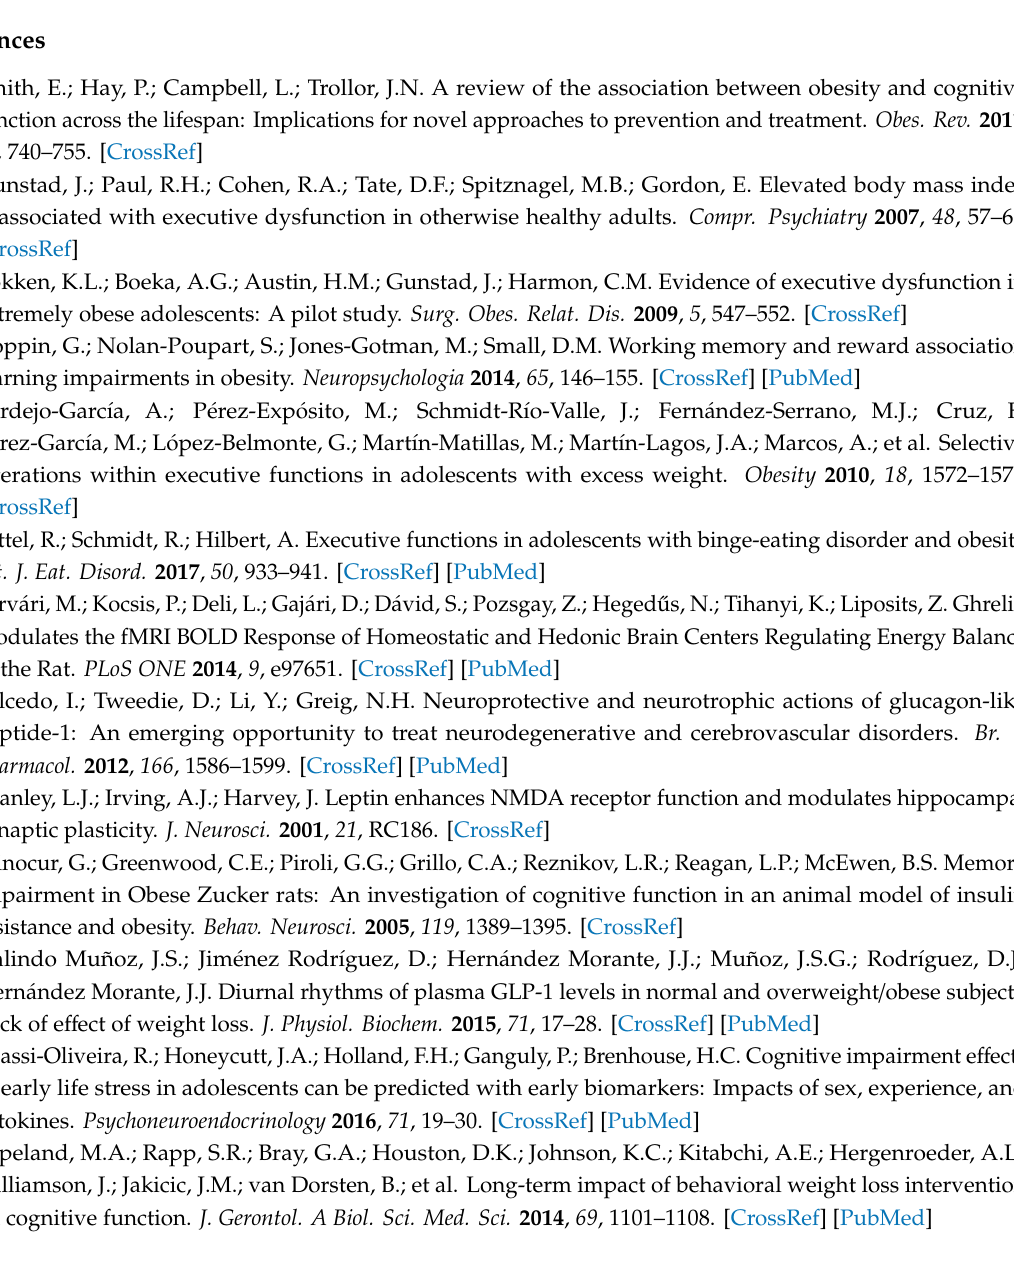
Figure S1: Baseline performance on the Iowa Gambling task for the five blocks of task execution in both CONTROL and COGNITIVE groups, Table S1: CONSORT 2010 checklist of the trial, Supplementary Information S-1: Neurocognitive Intervention Additional